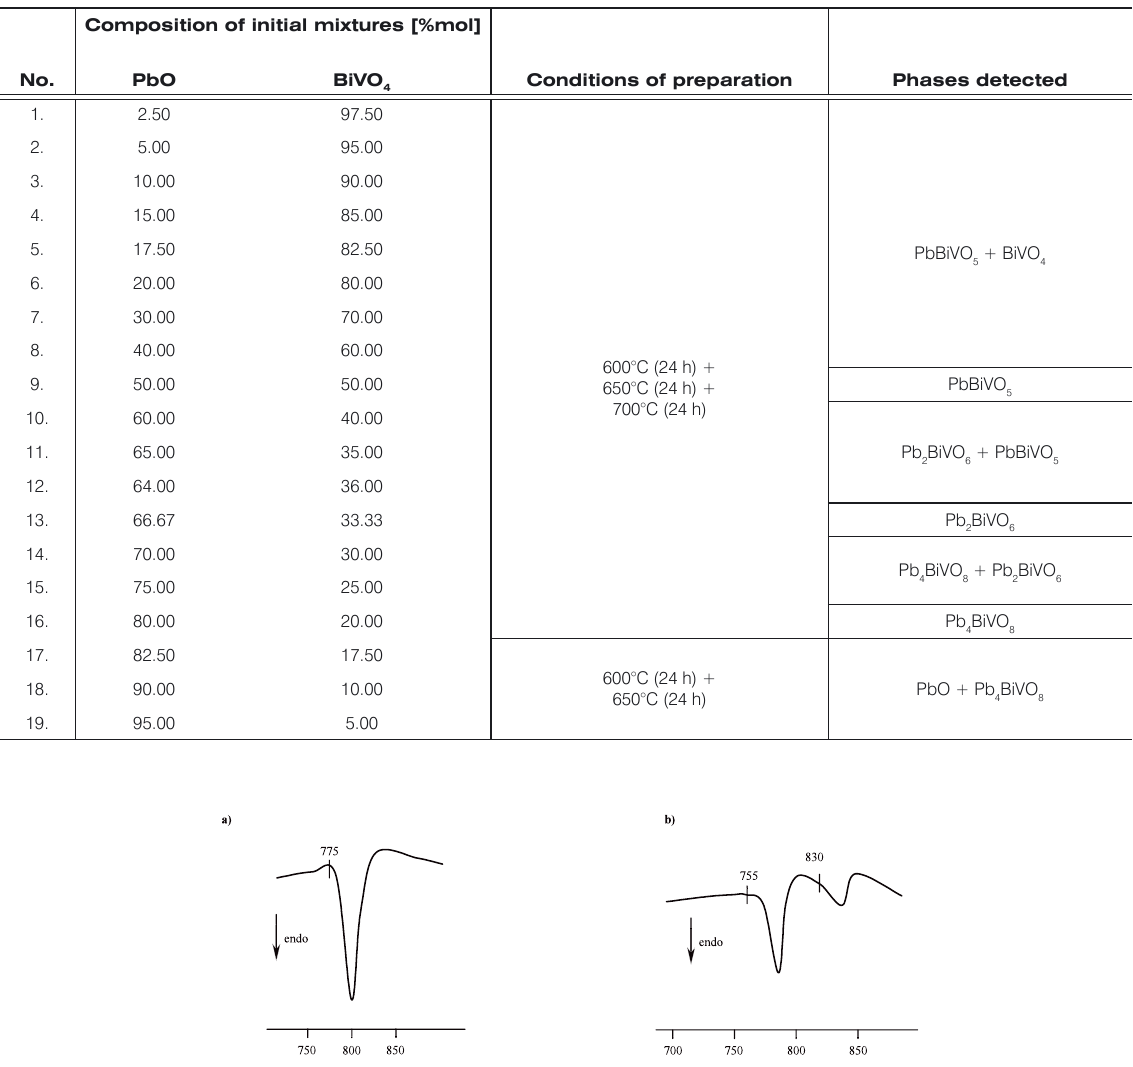
Table 1. Composition of initial mixtures, conditions of preparation and XRD results for samples after last heating